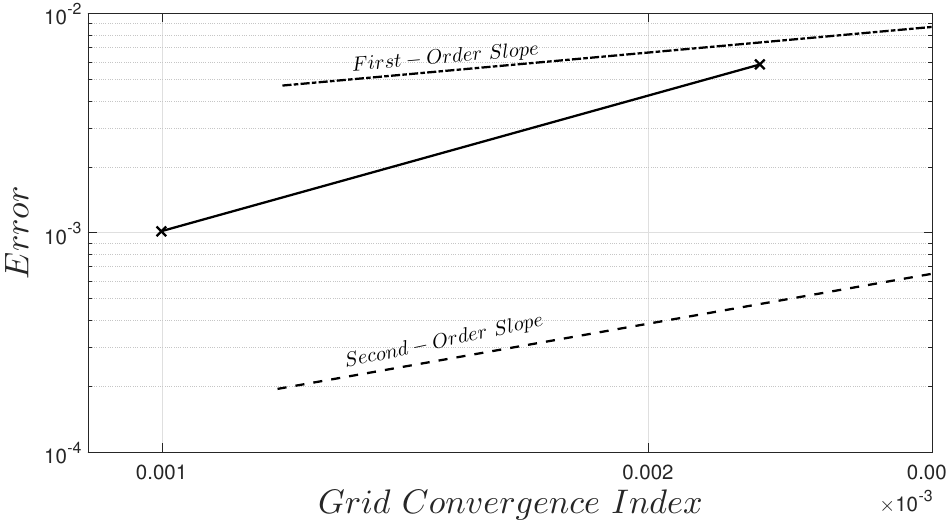
Figure 9. Comparison of grid independence study with Richardson’s